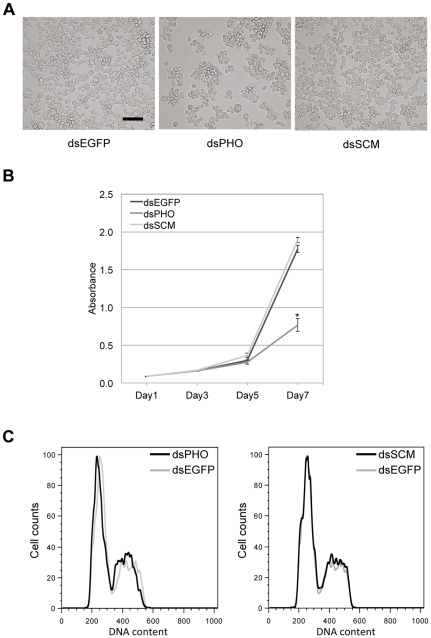
Knockdown of BmPHO inhibited cell proliferation.(A) Representative graphs of cells treated with dsRNAs against EGFP, BmPHO, or BmSCM, respectively. Scale bar: 50 µm. (B) Down-regulation of BmPHO suppressed cell proliferation by using WST-8 assay. *P<0.001, compared to the control of EGFP RNAi cells. (C) The distribution of cell cycle in dsRNAs treated cells was measured using flow cytometry. The merged results from PcG knockdown and control treatment were shown in each panel.